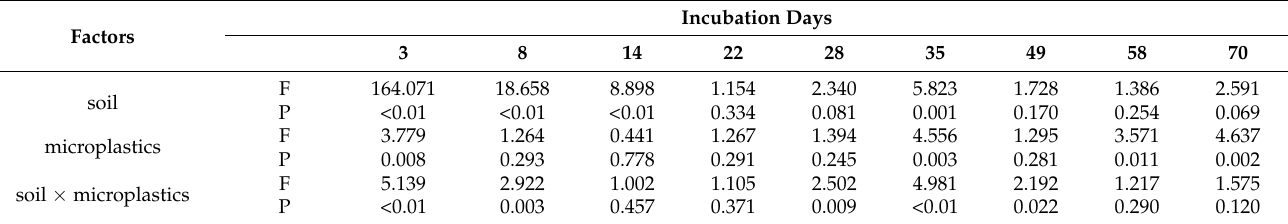
Figure 2. CH 4 concentrations in freshwater ecosystems after microplastics (HDPE, PVC, PA, PET) were added. ( a ) Poyang Lake ( b ) paddy soil. Table 2. One-Way ANOVA of soil and microplastics on CH 4